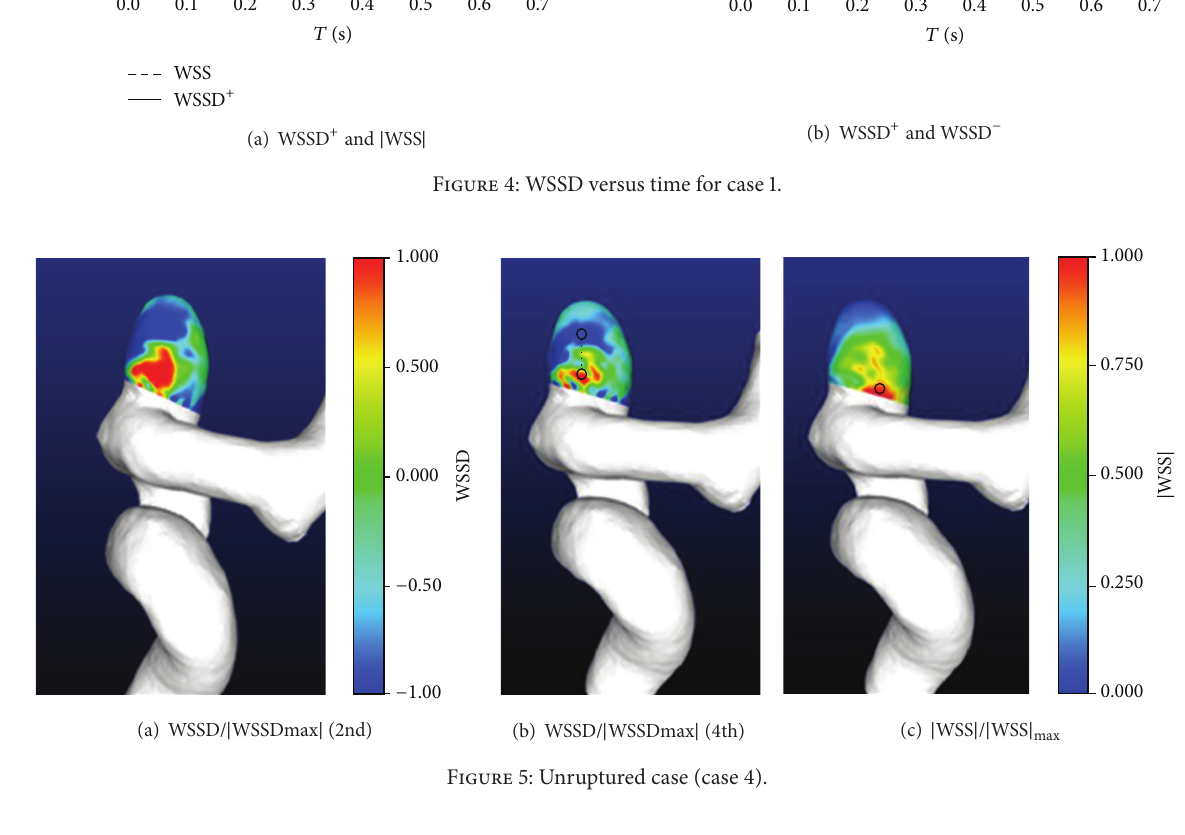
Figure 5: Unruptured case (case 4).